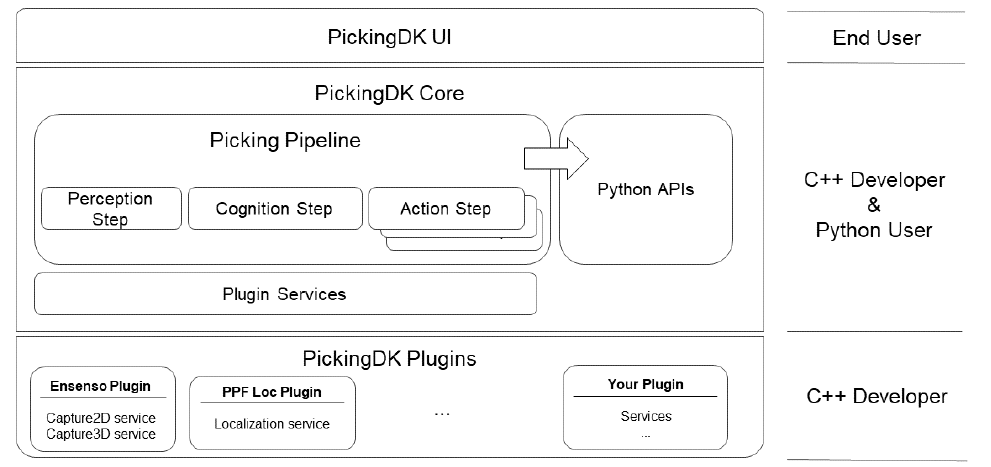
Figure 3. Users at different